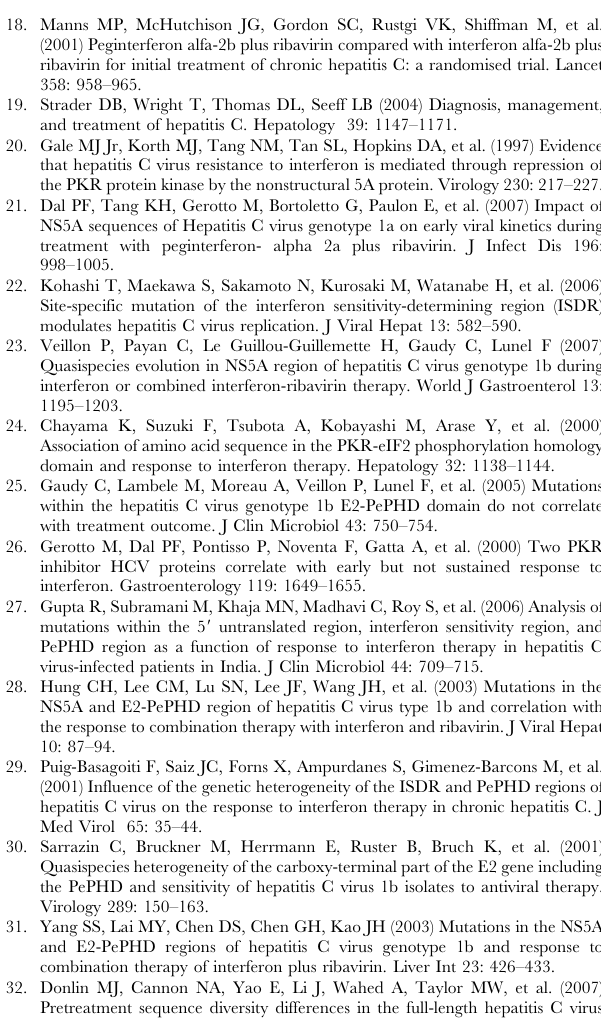
Figure S1 CONSORT flowchart. A depiction of how patients were selected from the main Virahep-C study for this study on viral